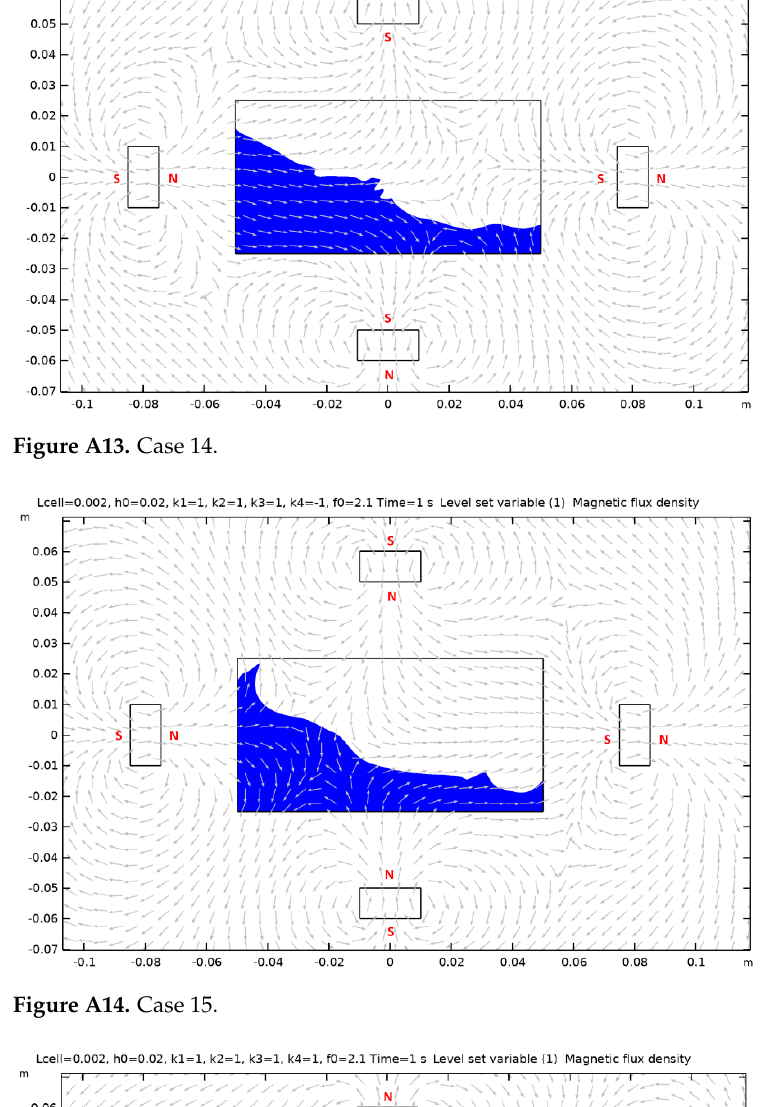
Figure A12. Case 13.